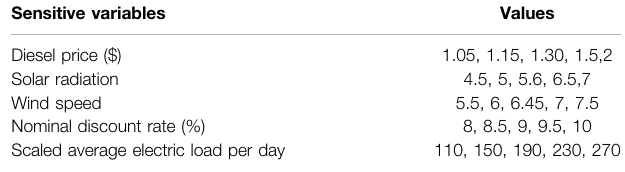
TABLE 13 | List of sensitive